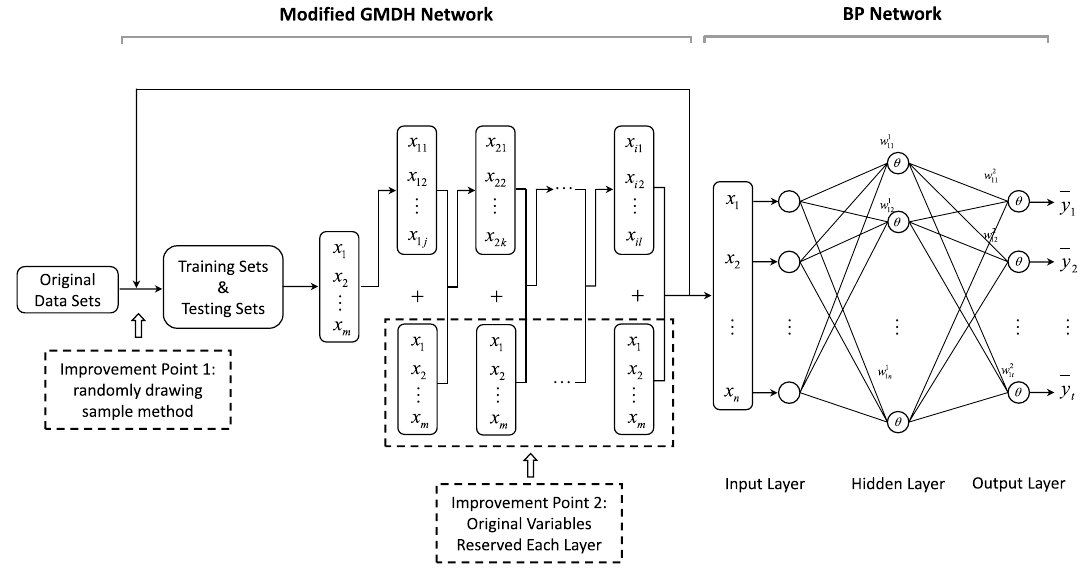
Fig. 2 Proposed structure of the hybrid model for predicting oil